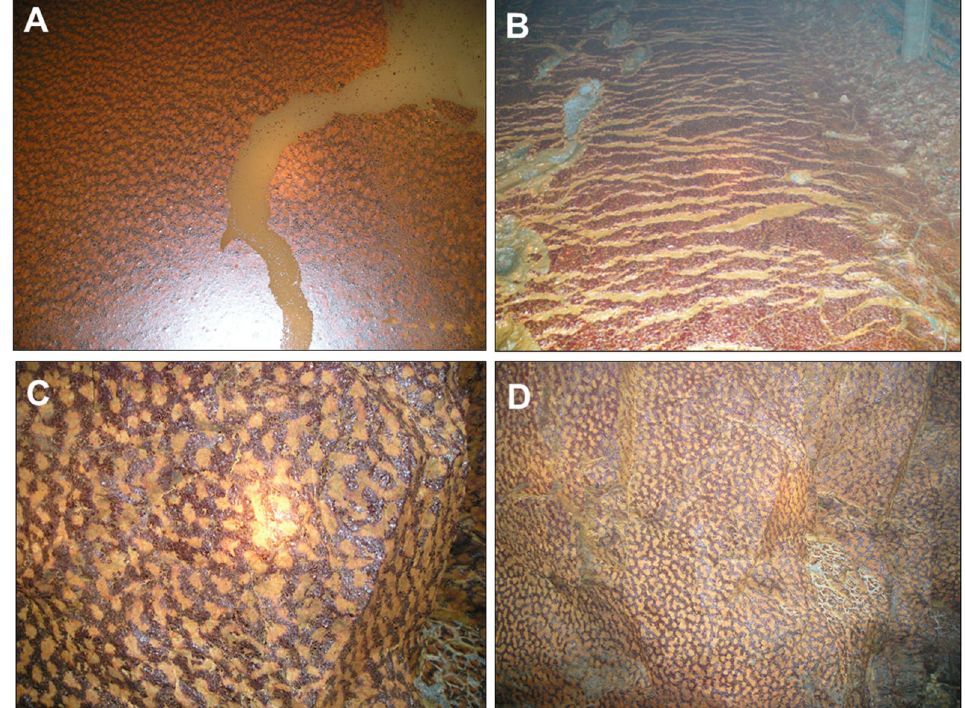
Figure 5. Iron-rich mineralized films found in the underground Aguas Teñidas mine (Huelva, SW Spain): ( A ) floating mineral film found in stagnant water in a mine tunnel; ( B ) mineral coating formed on water-saturated, pyrite-rich sediments deposited on the ground of a mine tunnel; ( C , D ) mineral coatings formed on wet gallery walls. The mineralogy of these biofilms was always dominated by ferrihydrite with minor amounts of other phases such as natrojarosite and brushite (see Section 3.3). Note the ocellated or “leopard-skin”-like texture of the biofilms in ( A , C , D